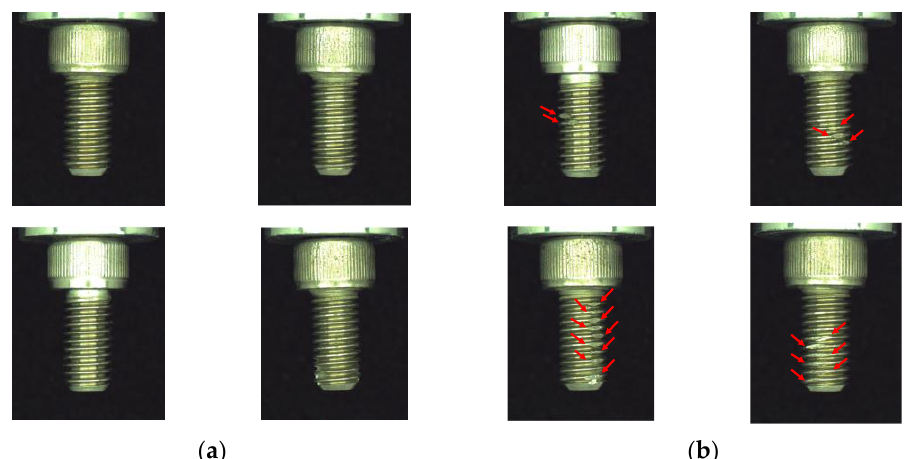
Figure 4. The developed system of the optical instrument.